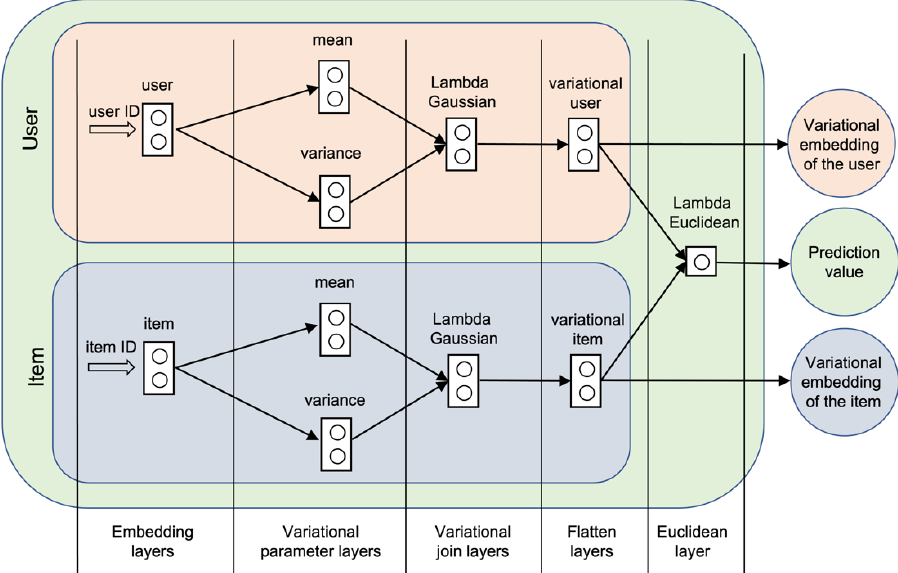
Figure 4. Proposed models: Green: collaborative filtering prediction; Orange: variational Euclidean model for users; Blue: variational Euclidean model for items.